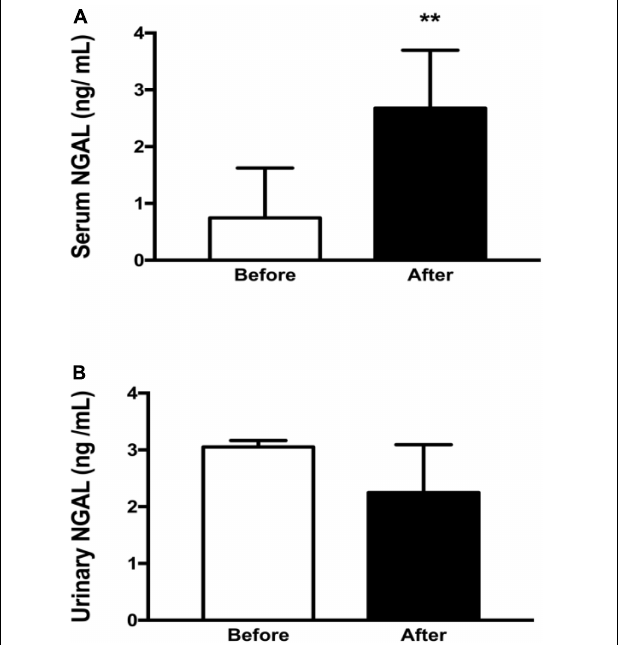
FIGURE 3 | Oxidative stress biomarkers of the athletes before and after the competition ( n = 7). (A) 8-isoprostane values before and after ultramarathon. (B) GPx activity before and after the ultramarathon. GPx, glutathione peroxidase; pg/ml − 1 , picogram per milliliter; u/g Hb, microgram per gram of hemoglobin. The ** means that the result was statistically significant ( p < 0.01).